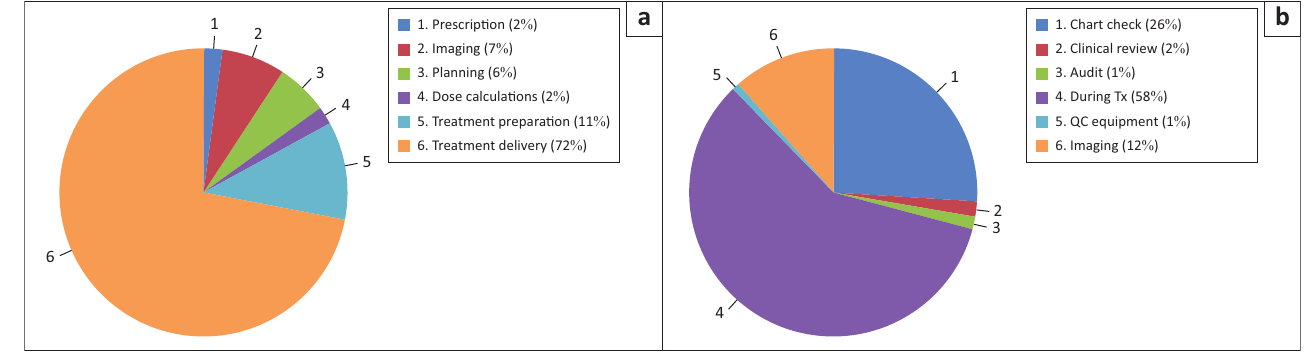
FIGURE 5: (a) Area of incidence in radiotherapy and (b) treatment preparation and